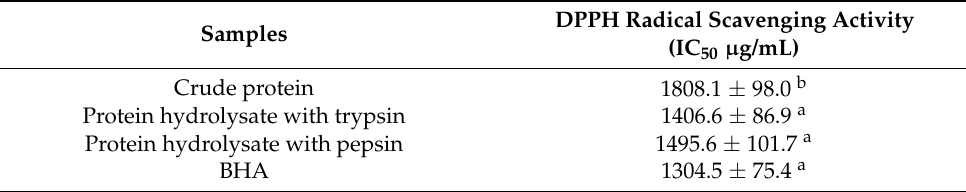
Table 1. DPPH radical scavenging activity of protein hydrolysates from S. ricini pupae.